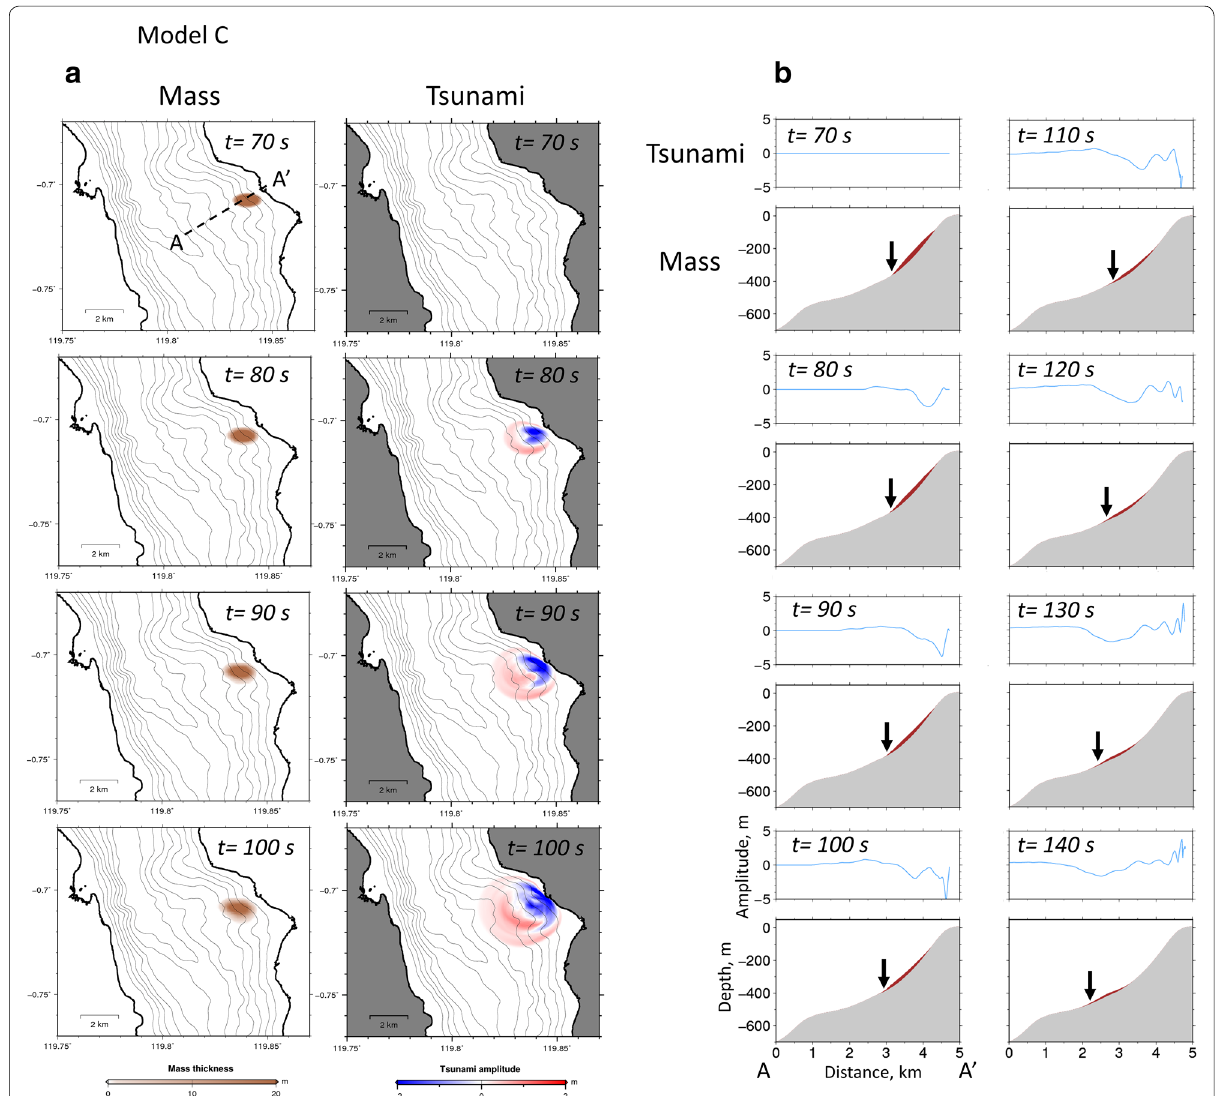
Fig. 6 Time-series of the calculated landslide mass motion and generated tsunami in model C. a Spatial distribution of mass thickness and tsunami amplitude at the sea level. b Cross-section along line A–A ′ in a . (bottom) Sliding mass motion. Black arrows indicate the 5-m-thick location taken as representative of the front of the sliding mass. (top) Tsunami propagation at the sea